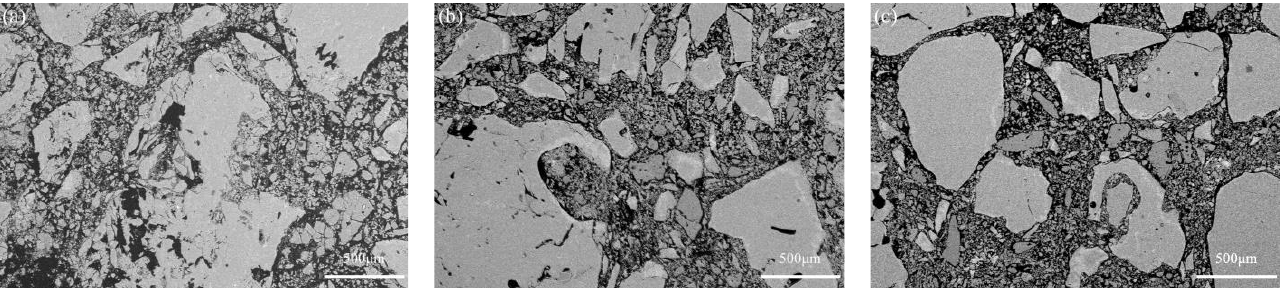
Figure 4. Microstructure of samples G0 ( a ), G4 ( b ), and G8 ( c ) sintered at 1600 °C for 3 h.